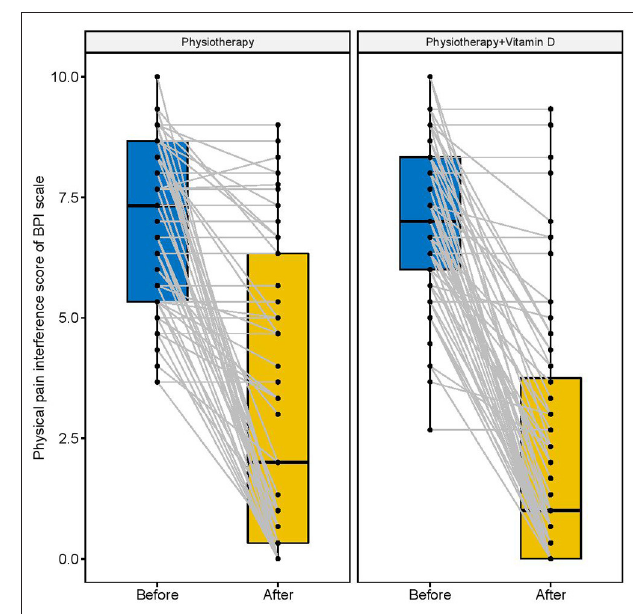
FIGURE 4 | Affective interference scores before and after the